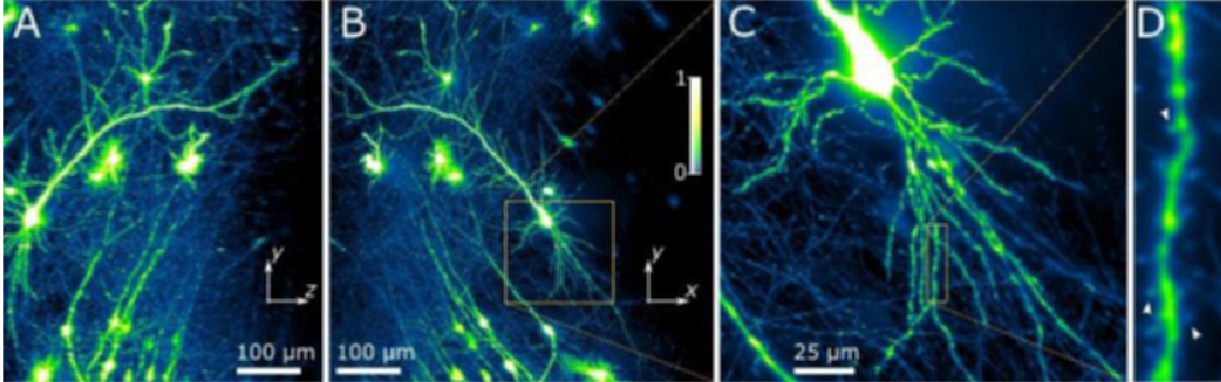
Fig. 2. Projections from a 3D volume of neuronal tissue, reproduced from Hosny et al. [9] (CC BY 4.0). Long-range connections between neurons can be seen in (A-B). A single neuron is highlighted in panel (B) and enlarged in panel (C). A single neuron dendrite is highlighted in panel (C) and enlarged in panel (D). Its dendritic spines are visible in panel